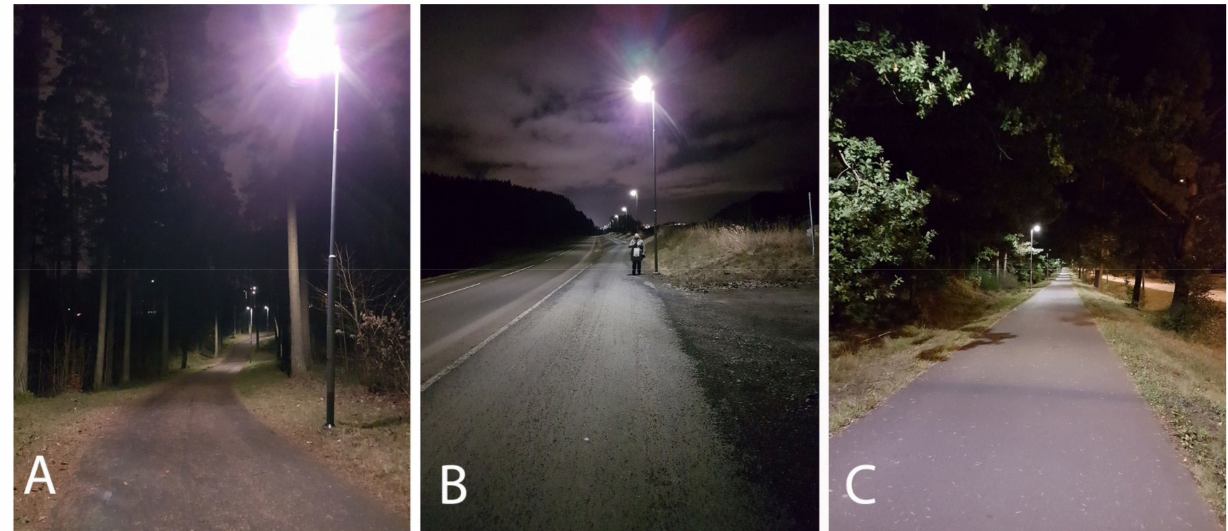
Figure 2. On the photos, we see the roads from left to right: ( A ) Råslätt; ( B ) Lockebo; ( C )